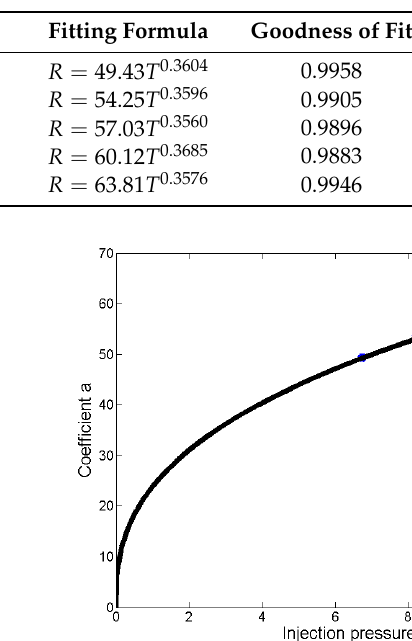
Figure 6. Microdroplet generation based on the substrate-contacting method, where the radius at the micropipette opening is 2.2 μ m. ( a ) The images of microdroplets at 20 s, 40 s, 60 s, 80 s, and 100 s, and the five rows of images correspond to the five groups of experiments, respectively; ( b ) microdroplets’ radii of five groups of experiments within 100 s. They are fitted with the equations in Table 2 (the black curve), with r 2 > 0.98. Table 2. The fitting results of five experiments, with the radius at the micropipette opening of 2.2 μ m. T (unit: s) is the injection time; R (unit: μ m) is the radius of the microdroplet.